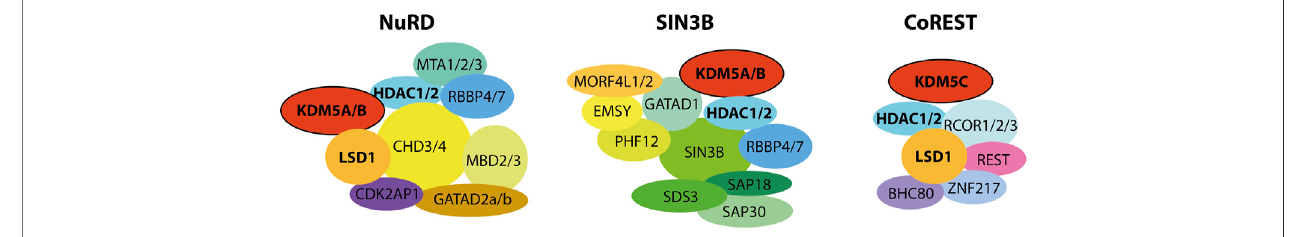
FIGURE4| KDM5demethylaseswereshowntophysicallyandfunctionallyinteractwithHDACcomplexes.InteractionswiththeNuRDandSIN3Bcomplexeshave been shown for the mammalian KDM5A and B proteins, as well as Drosophila Lid. CoREST interactions were shown for KDM5C, with implications for neuronal development. Note that, for reasons of clarity, the stoichiometry and detailed subunit composition of the complexes was neglected. For NuRD and SIN3B, composition and dynamics of subunits are subject to research and have not been de fi nitely established. The placement of subunits and their proximity to each other and to the KDM5 proteins does not re fl ect experimentally veri fi ed proximity within the respective